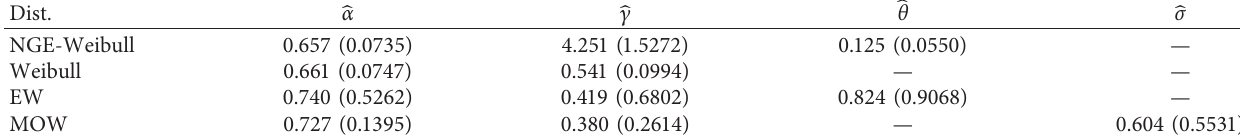
Table 3: The MLEs with standard errors of the competing models for the failure time data. Dist.